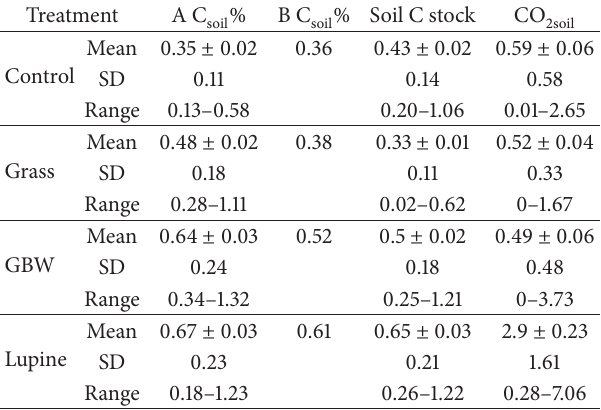
Table 1: Summary results of soil carbon analysis and soil CO 2 flux measurements. 𝑁 = 50 for control and lupine; 𝑁 = 75 for grass and GBW (grass-birch-willow). Mean shown ± standard error. SD